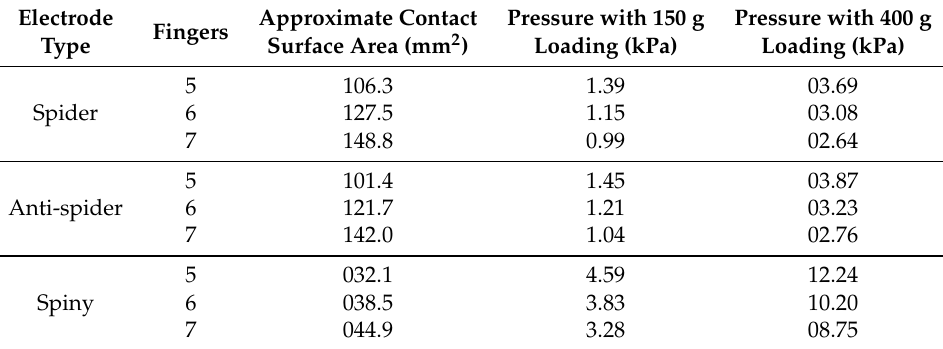
Table 1. Summary of the 9 electrode configurations used in this